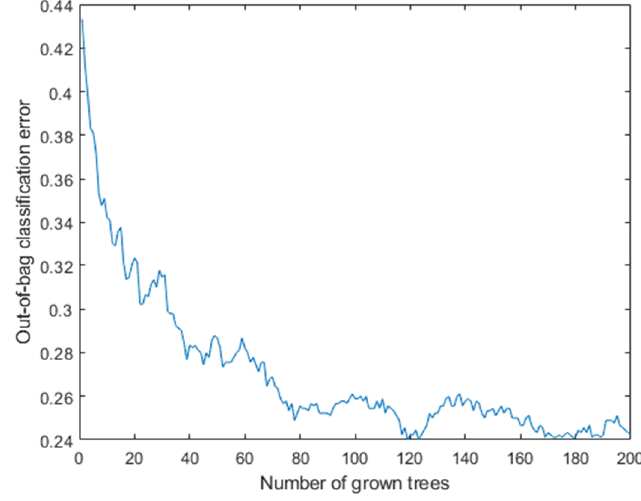
Figure 11. The out-of-bag error over the number of grown classification trees.